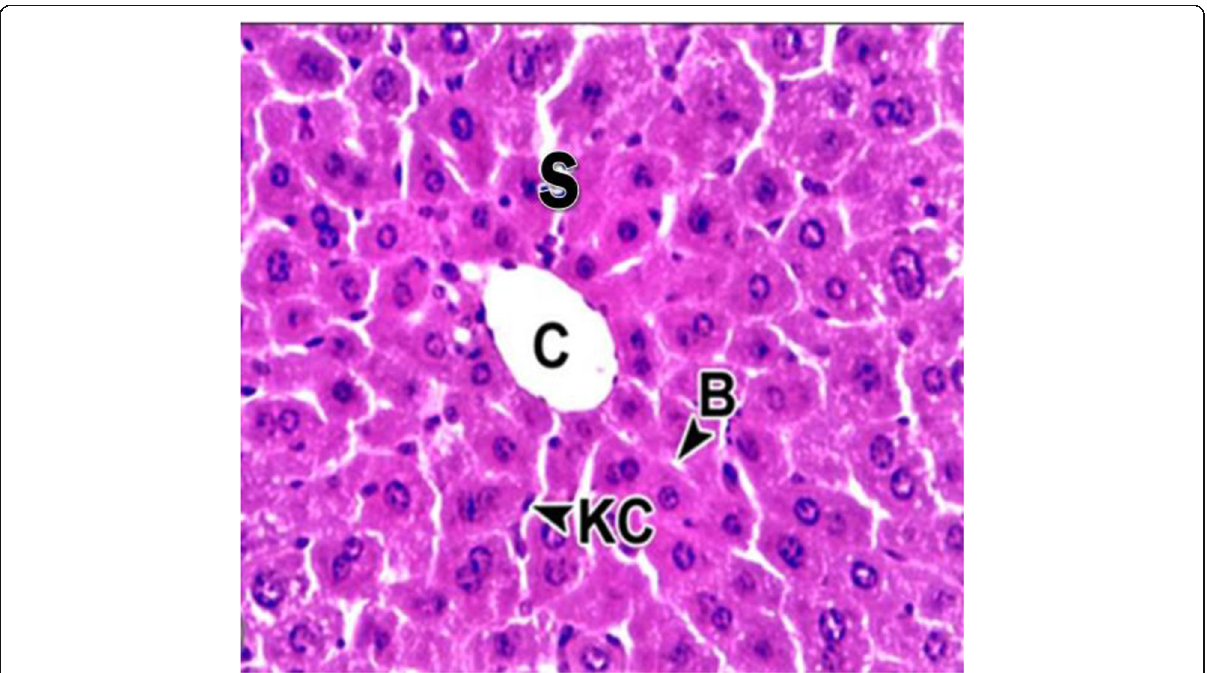
Fig. 1 Photomicrograph of a section of the liver of control mouse showing the central vein (C). Notice the blood sinusoids (S) are seen between the hepatic strands. Kupffer cells (KC) intervenes the walls of the sinusoids. (H&E, ×